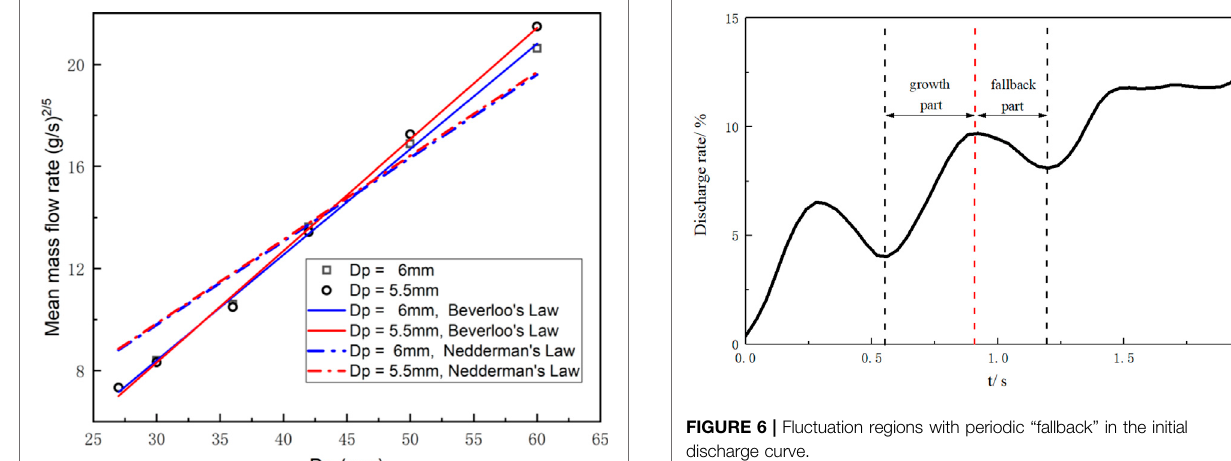
TABLE 2 | Coef fi cients C, k, R 2 and σ 2 corresponding to the two empirical formulas. Pebble diameter D p (mm)